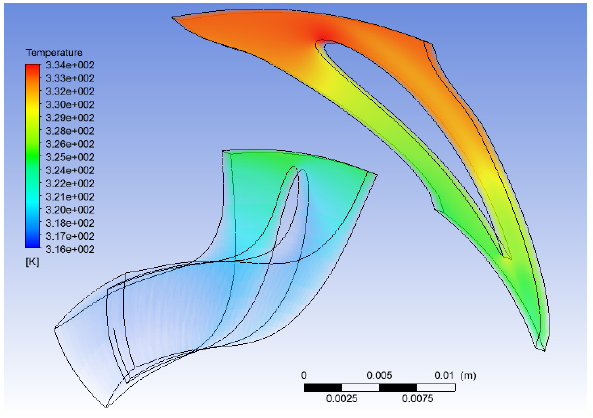
Figure 24. CFD study results: Temperature (R134a).